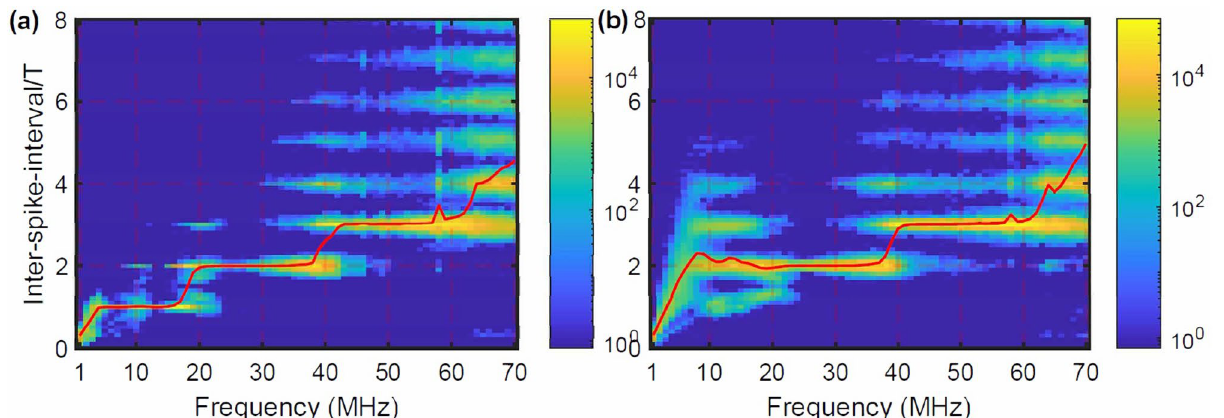
Figure 2. Inter-spike-interval (ISI) distribution in log color code for pulsed ( a ) and for sinusoidal ( b ) modulation, as a function of the modulation frequency; other parameters are as in Fig. 1b. The solid line indicates the mean ISI normalized to the modulation period. The plateau at low frequencies for pulsed modulation [panel ( a )] where � ISI � / T mod = 1 is not seen in panel ( b ), where the modulation is sinusoidal.